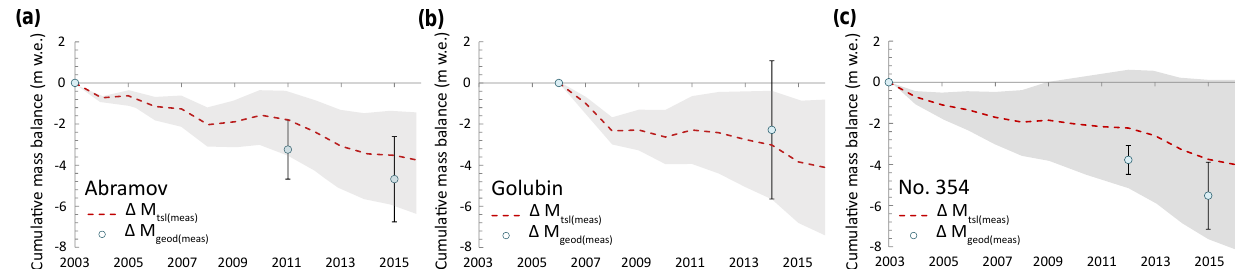
Figure 11. Cumulative TSL-constrained modelled mass change (cid:49)M tsl ( meas ) (red) in comparison to the geodetic mass change (cid:49)M geod ( meas ) (circles) for (a) Abramov, (b) Golubin and (c) Glacier no. 354. The shading indicates the uncertainty range of the mass change from the snow line approach.